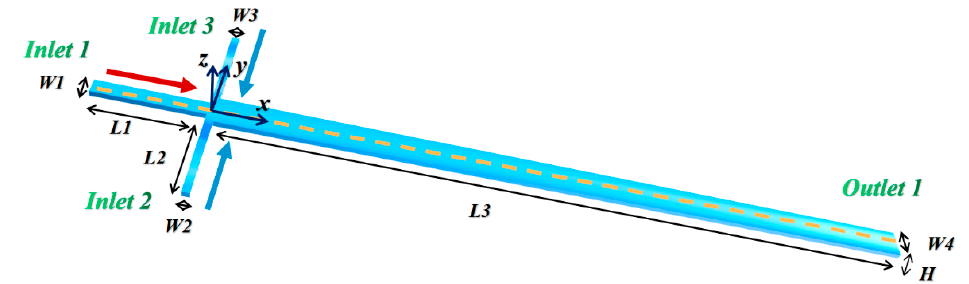
Figure 2. The geometrical structure of the cross-shaped micromixer.